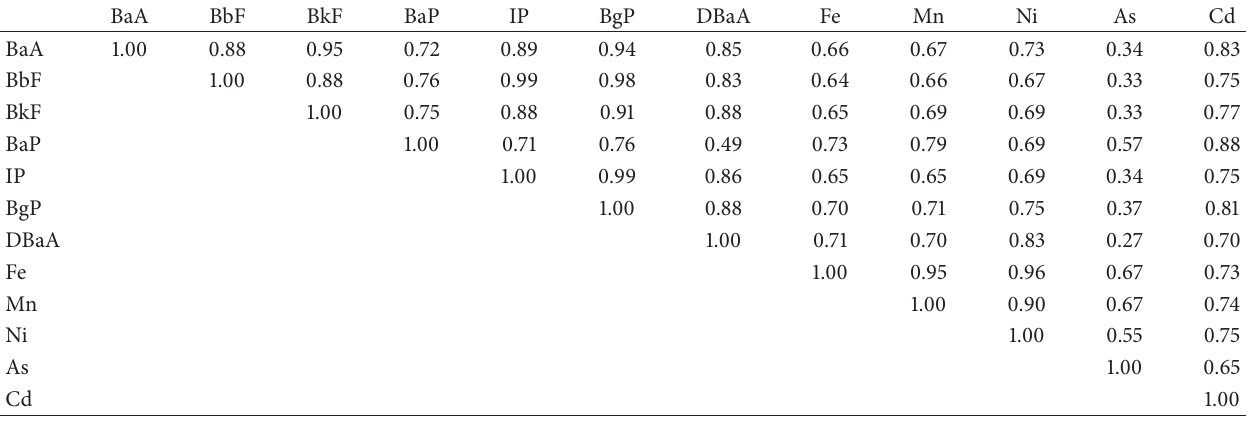
Table 5: Correlation coefficients among PAHs and metals collected at the industrial site.